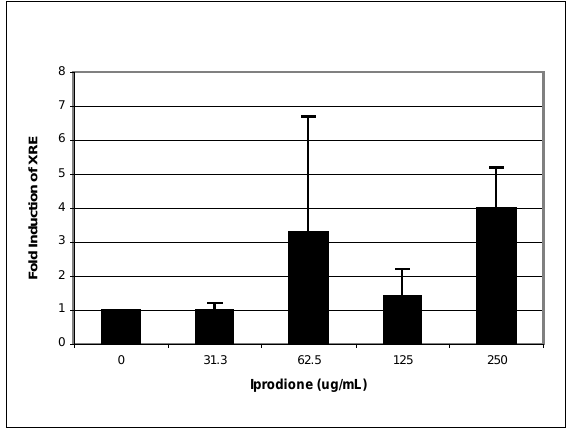
Fig. 3: Fold induction of XRE in HepG